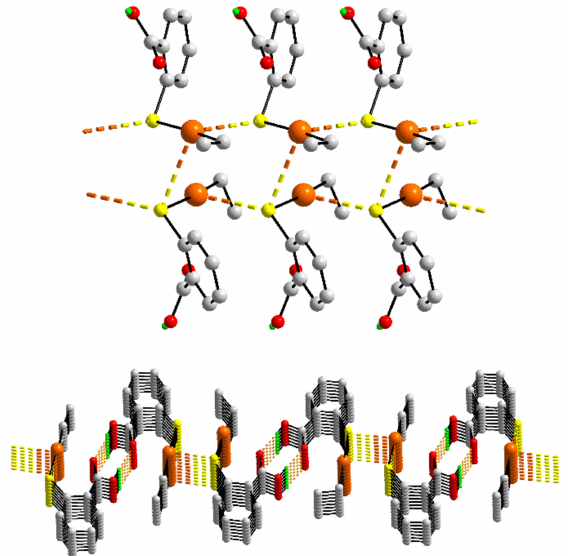
Figure 13. Supramolecular association in the crystal of 40 : upper view—a one-dimensional aggregate with a ladder topology featuring three independent Hg ··· S interactions; lower view—side-on view of the supramolecular layer formed through the agency of carboxylic acid-O–H ··· O(carbonyl) hydrogen bonding and { ··· HOCO} 2 synthons. Here, the chains of the upper view are connected into a two- dimensional assembly via the hydrogen bonding (non-participating hydrogen atoms are omitted).